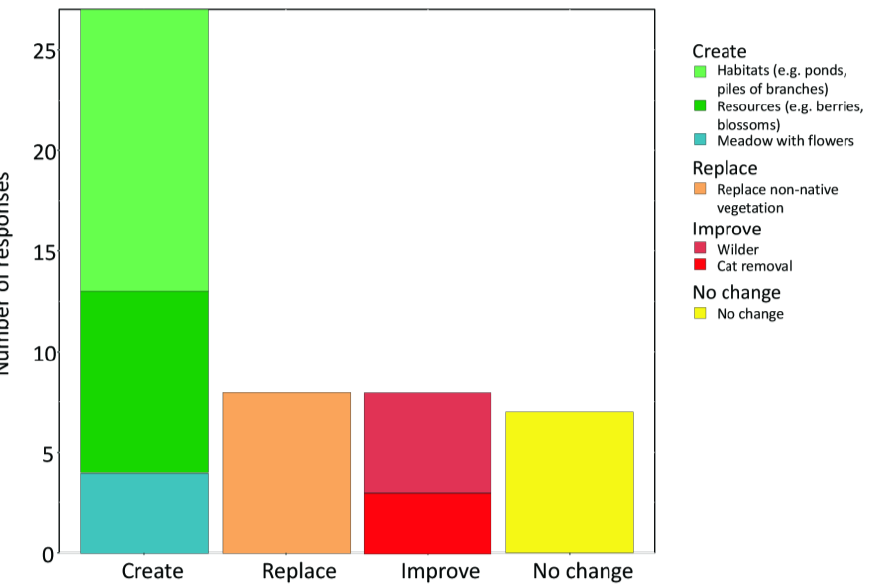
Figure 3. Owners’ suggestions on how to further promote biodiversity in their gardens. Answers to the open question “Do you see potential ways to increase the biodiversity in your garden?” by interviewed garden owners. Multiple answers were allowed. Answers were later assigned to four main categories.